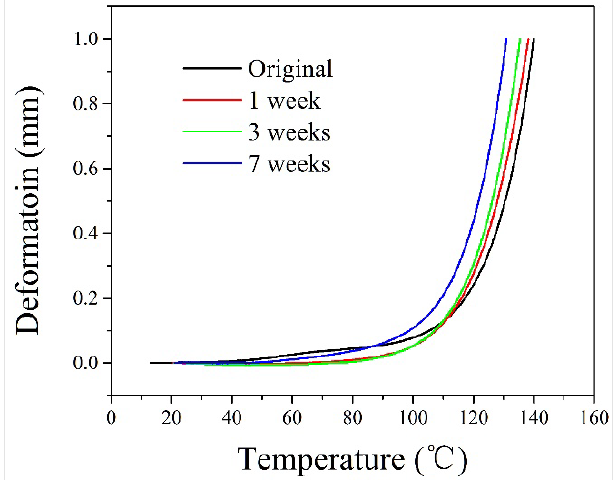
Figure 6. The Vicat softening temperature test results.